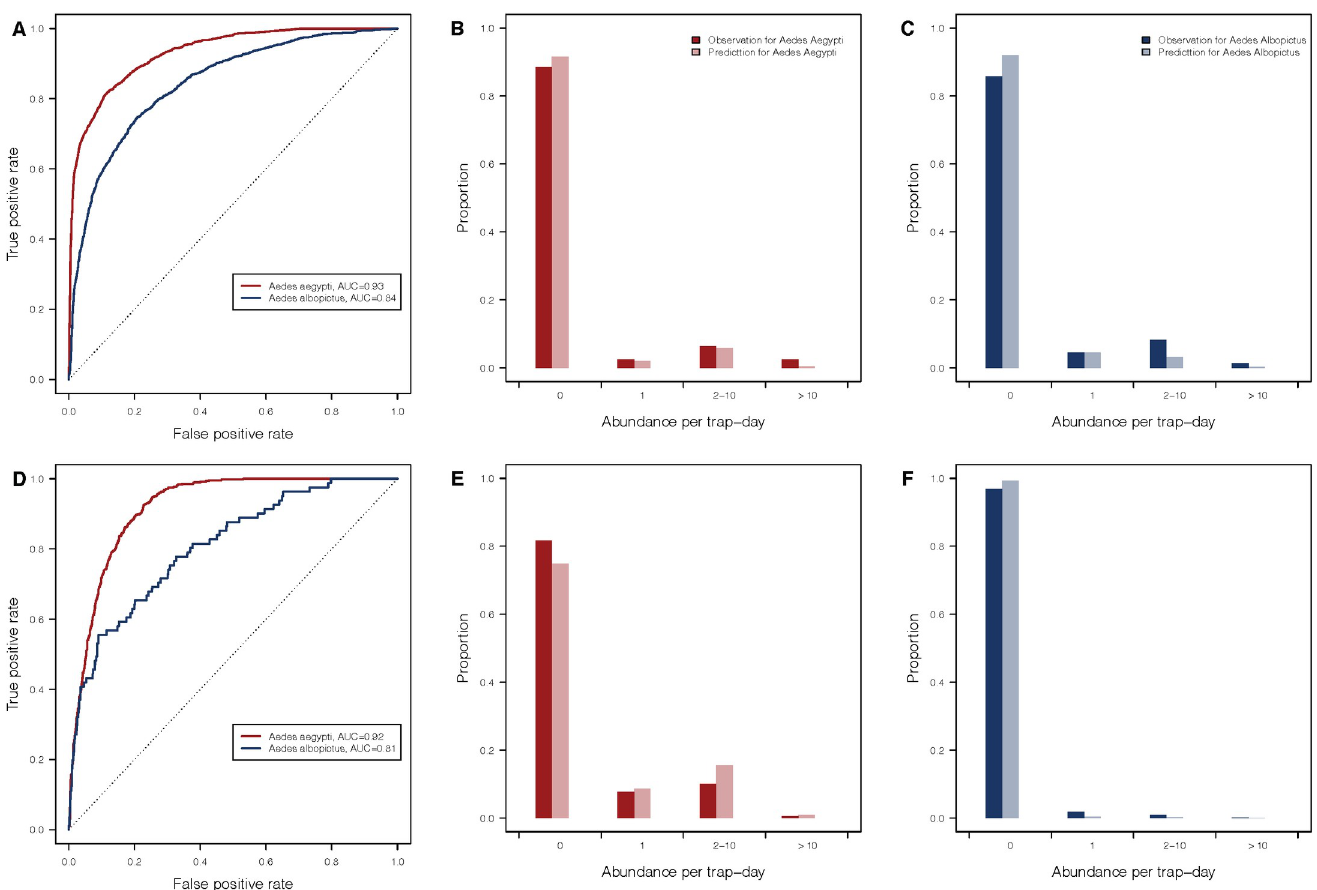
Fig 3. Model performance of predictions in occurrence and abundance of Aedes aegypti and Aedes albopictus for cross-validations. (A-C) Records from 10% of trap sites were randomly selected as the test set and records from the rest of the traps were the training set. (D-F) Records from 2003 to 2016 were selected as the test set and records during and after 2017 were in the training set. The model was fit to the training set and predicted the test